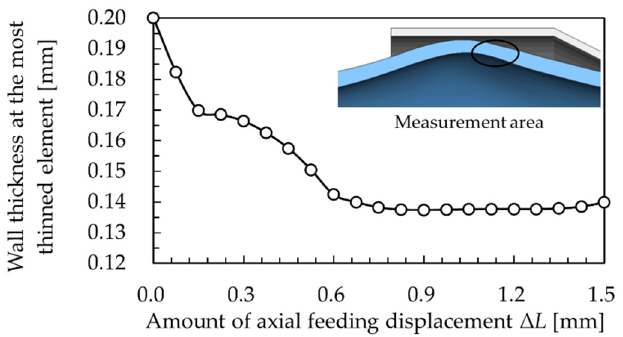
Figure 18. Thinning behavior of the wall thickness in the cylinder-shape warm THF obtained by FEM.